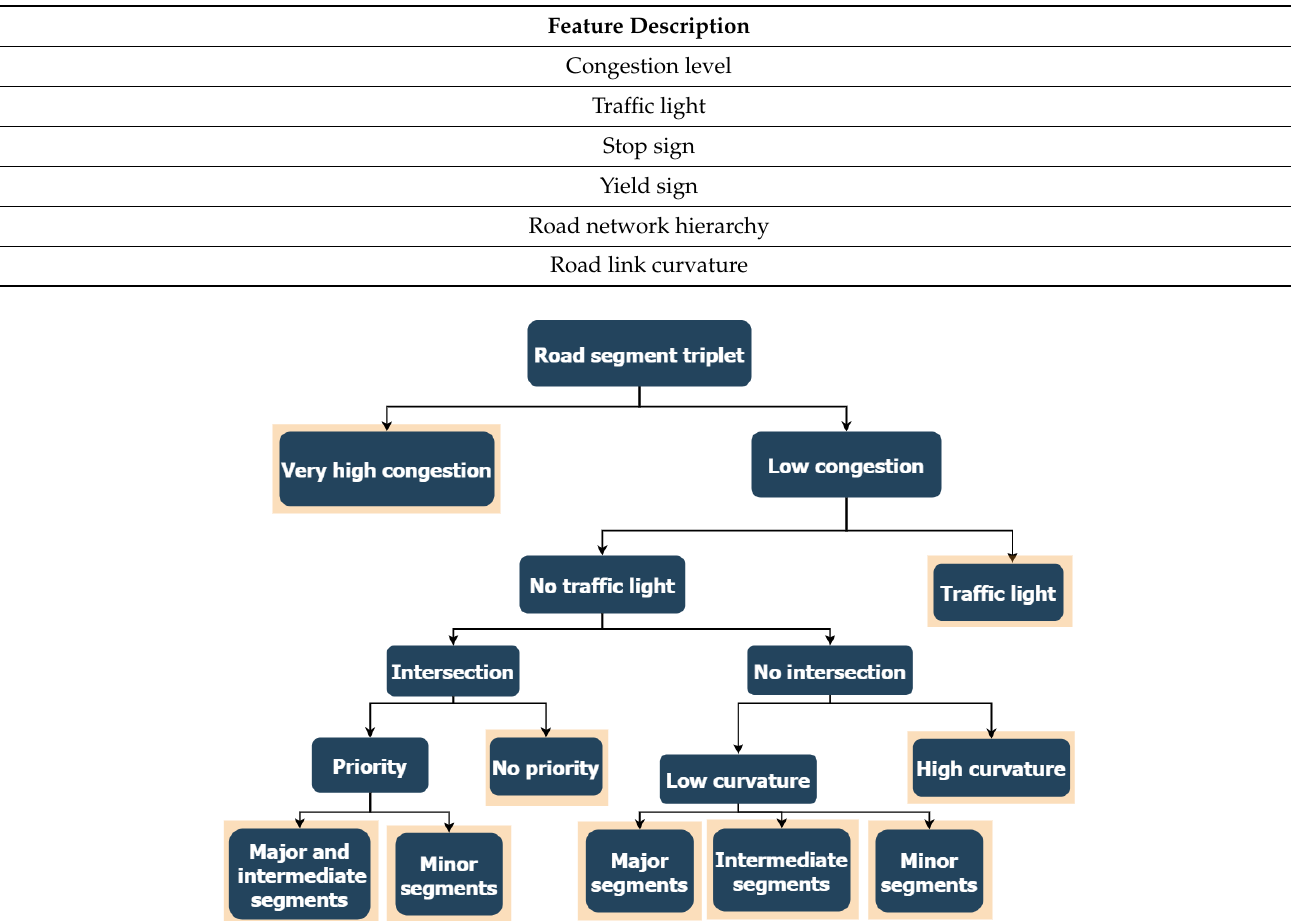
Figure 3. Proposed decision tree, nine categories are